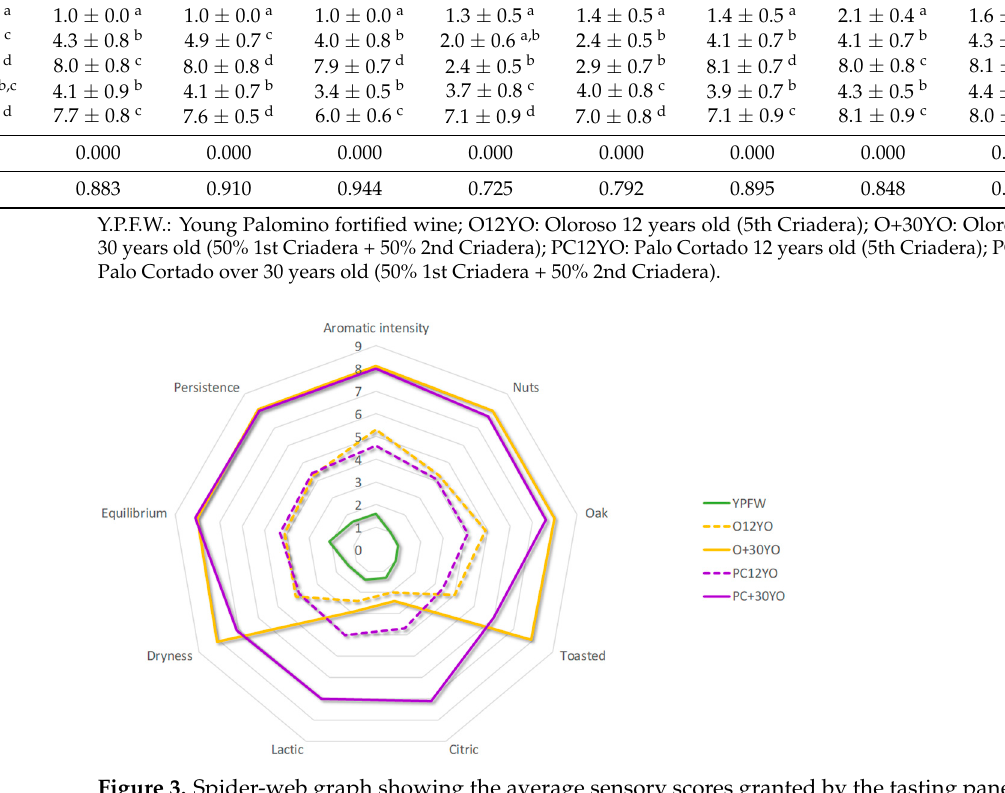
Figure 4. Projection of the wines according to the factorial analysis of the data on the plane formed by Factors 1 and 2. Figure 5 shows the weights of the sensory descriptors in the factorial space obtained from the first two factors, which should allow us to confirm the relevance of these factors when attempting to establishing a differentiating profile for the various wines. Factor 1 (66.8%) F a c t o r 2 ( 27 . 3 % ) -2,0